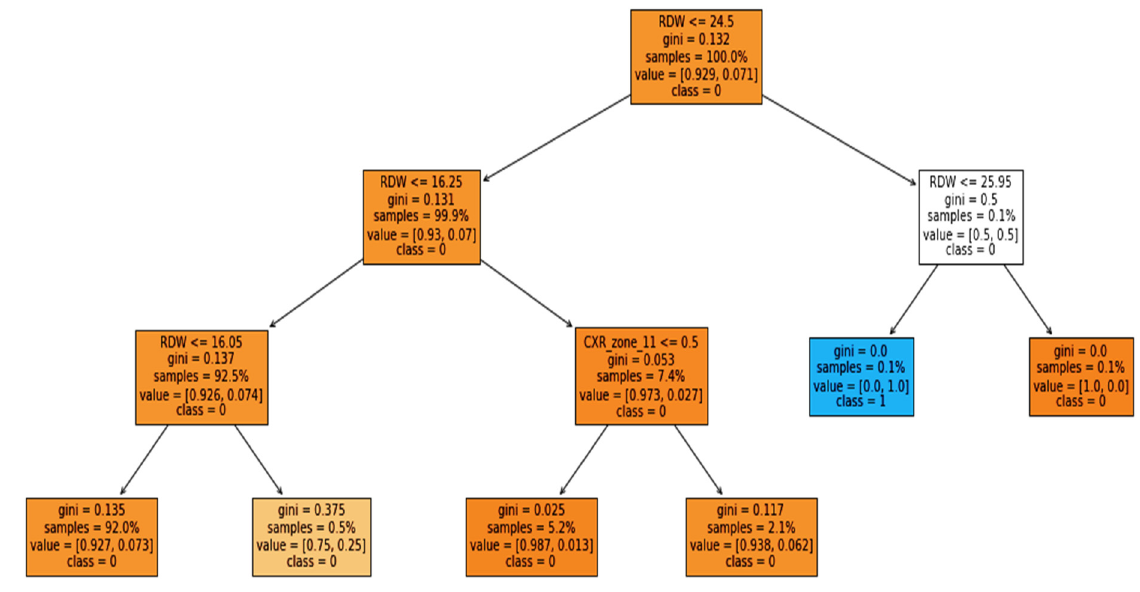
Figure 12. Case 2: Ventilator with multiclassification.